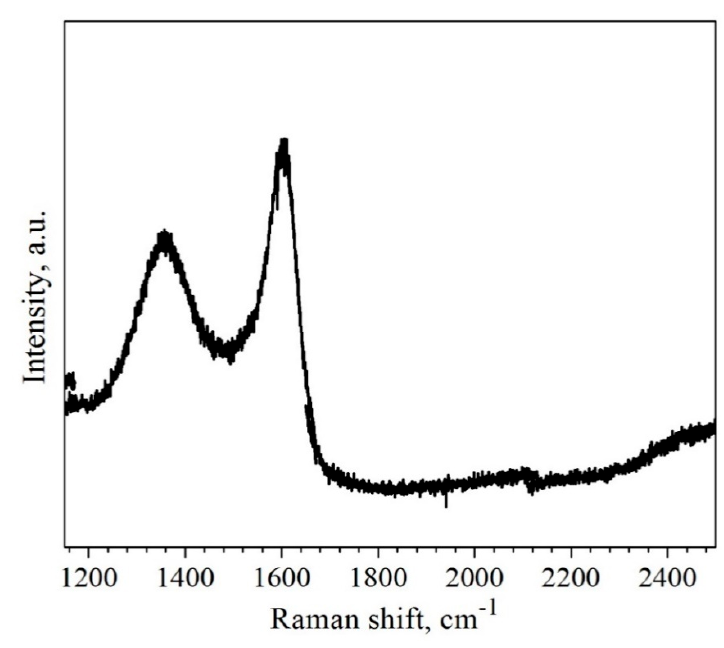
Figure 1. Raman spectrum of the synthesized reduced graphene oxide (rGO) powder.